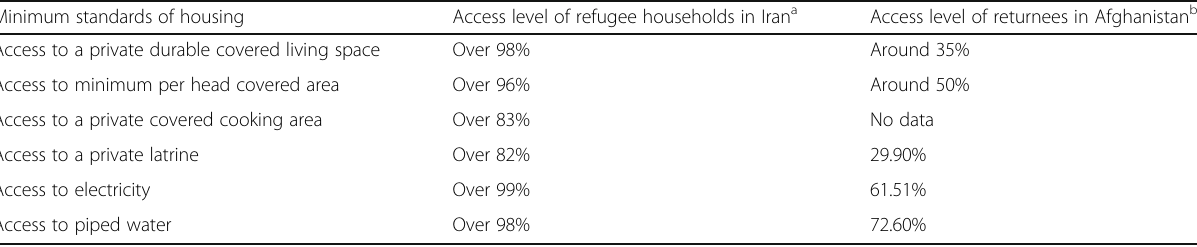
Table 2 Comparison of Afghan refugees ’ and returnees ’ housing and standards of living Minimum standards of